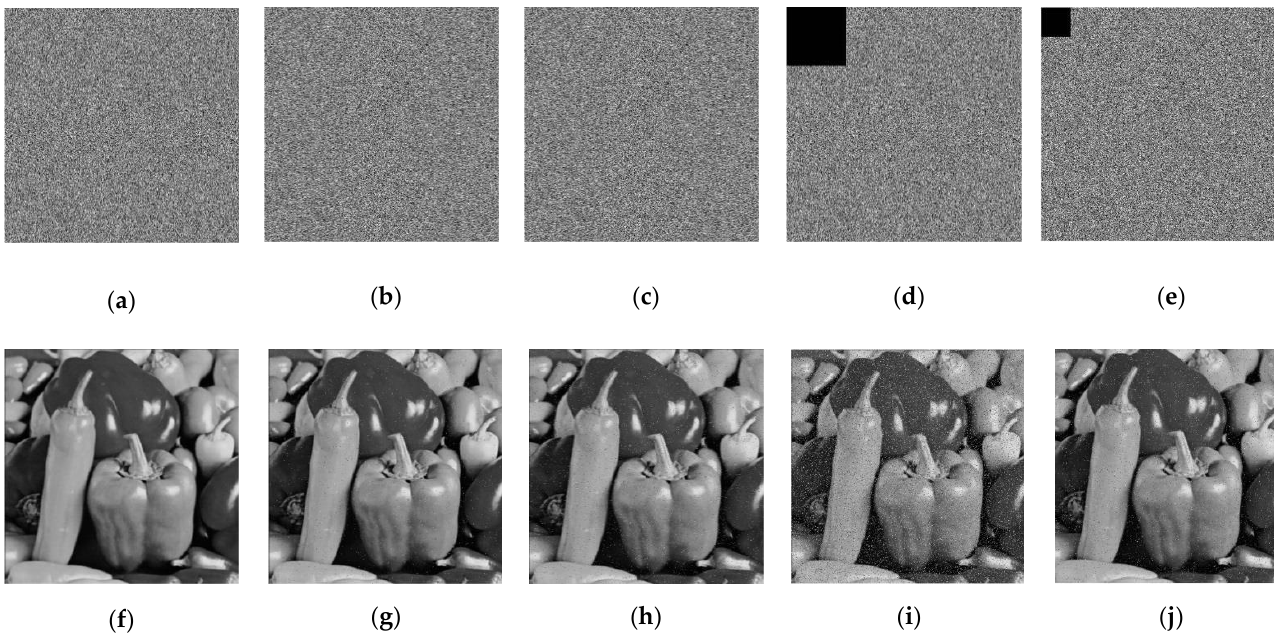
Figure 2. ( a ) The encrypted image, ( b ) noisy encrypted image with 0.002, ( c ) noisy encrypted image with 0.005 and ( d ) encrypted image with 128 × 128 data cut. ( e ) Encrypted image with 64 × 64 data cut. ( f ), ( g ), ( h ), ( i ), and ( j ) Decrypted images of ( a ), ( b ), ( c ), ( d ), and ( e ).